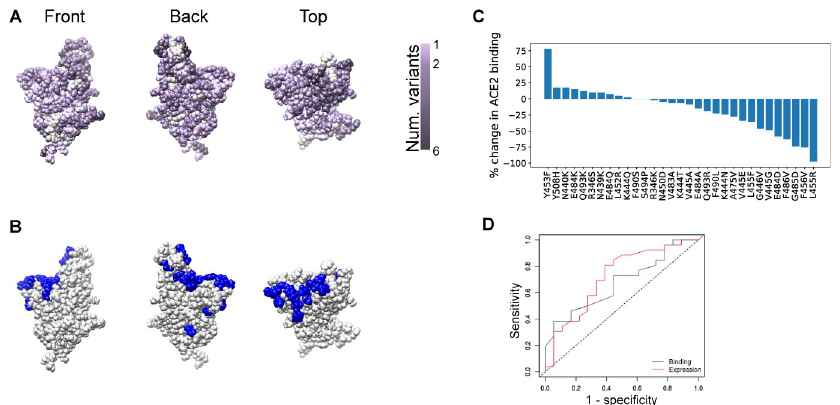
Fig 2. The spike protein RBD tolerates mutations that confer resistance to one or more nAbs. A. Spike protein RBD structure, with each residue colored by the number of distinct amino acid changes present in the GISAID sequencing database. B. RBD structure with residues at which mutations have been shown to confer escape from antibody neutralization marked in blue. C. Experimentally-measured effects of immune escape mutations on ACE2 binding, as taken from [17]. D. ROC curve showing the low predictive value of ACE2 binding measurements (grey) and expression (red) for in vitro infectivity of SARS-CoV-2 mutants. Area under the curve (AUC) is 0.67 for ACE2 binding as a predictor of infectivity and 0.72 for RBD expression as a predictor of infectivity. Taken together, the narrow focus of the immune response on a specific region of the RBD (Fig 1), the immunodominance of the spike protein [12], and the ability of RBD nAb escape mutations to yield viable and infectious viral particles capable of ACE2 binding (Fig 2) suggest a low evolutionary cost for the virus in generating escape mutants for nAbs.